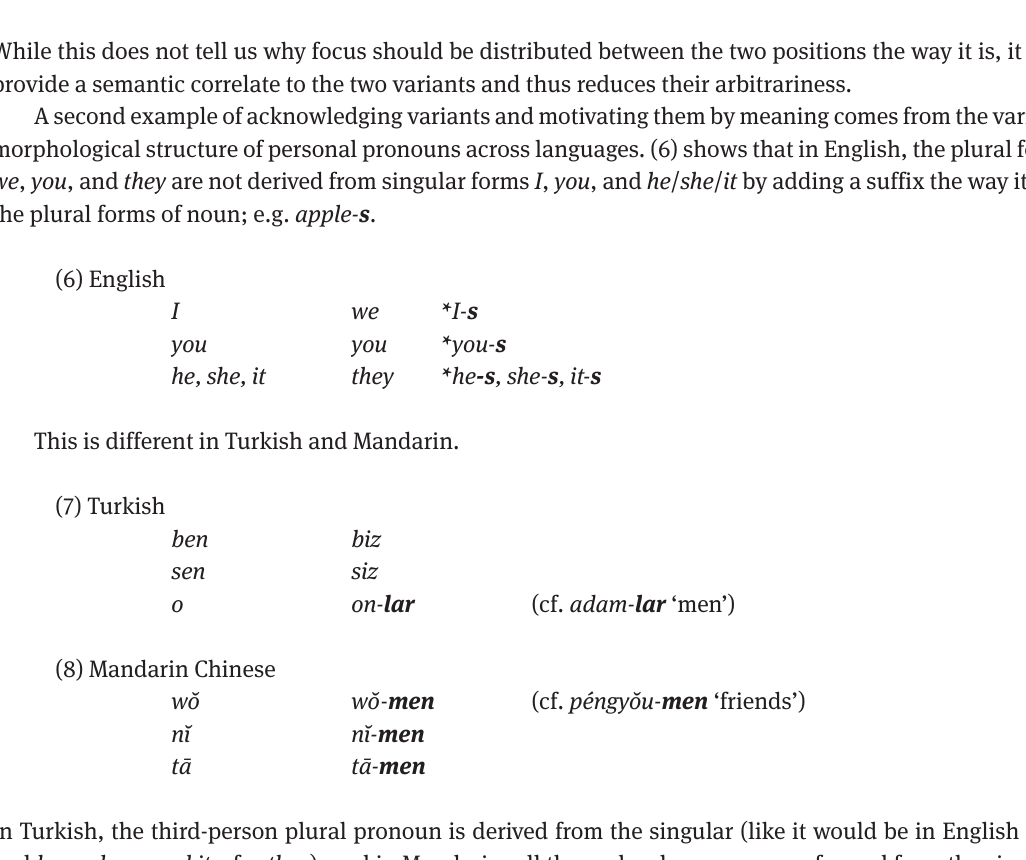
Figure 5: Motivating variants by meaning (English